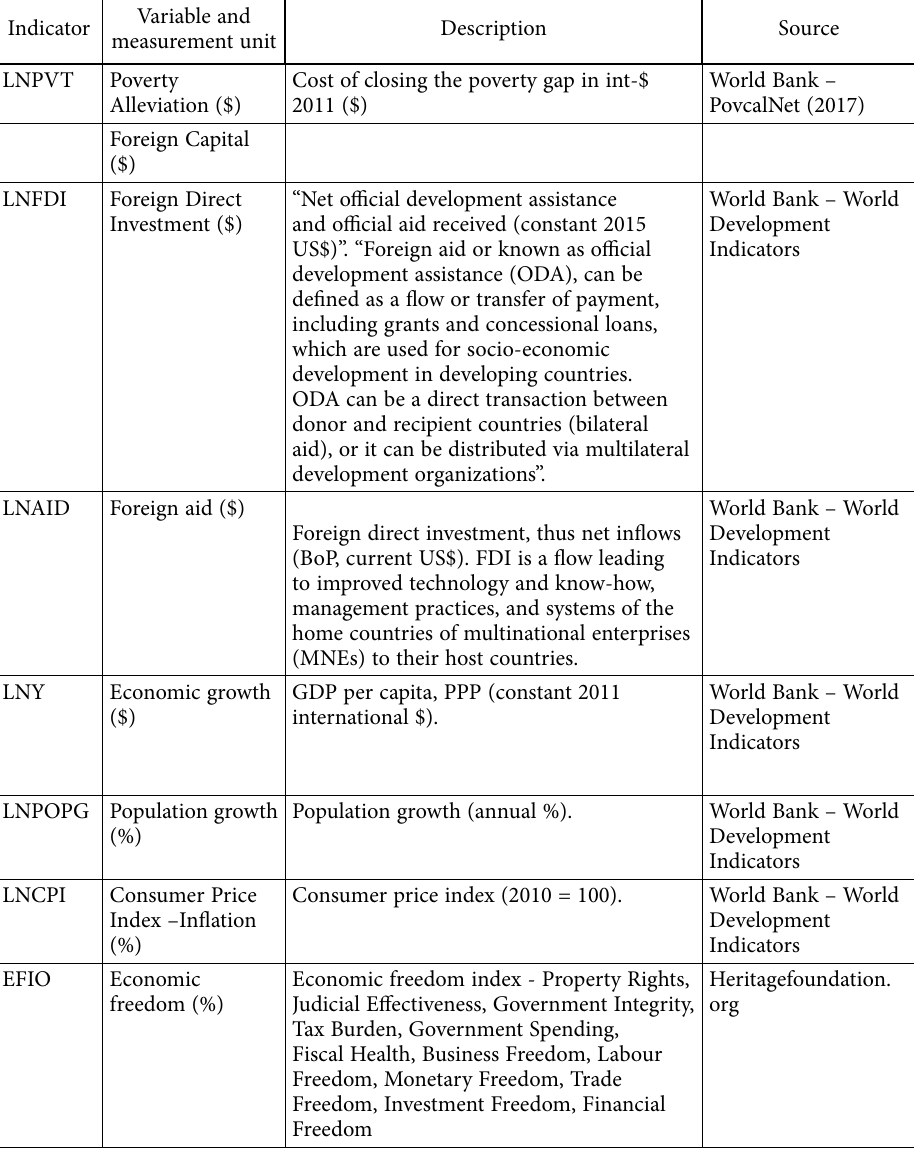
Table 1. Variables description and data